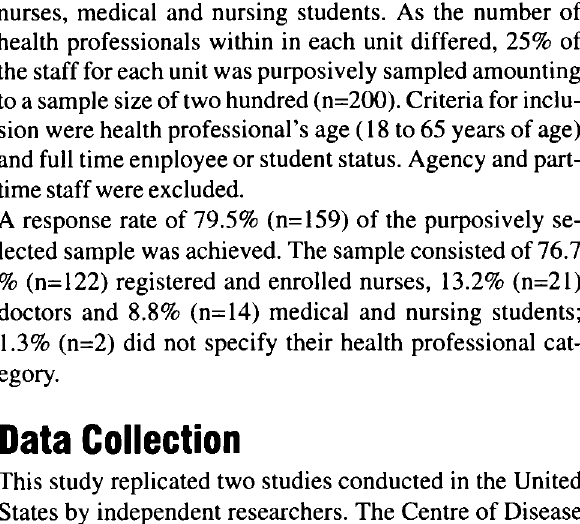
Table 1 : Awareness and content knowledge of